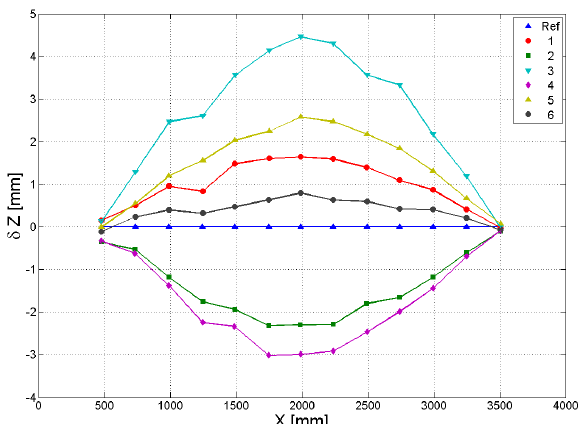
Figure 11. Plot of the beam deflections for a three second sample interval during the 1Hz load cycles of the dynamic portion of the